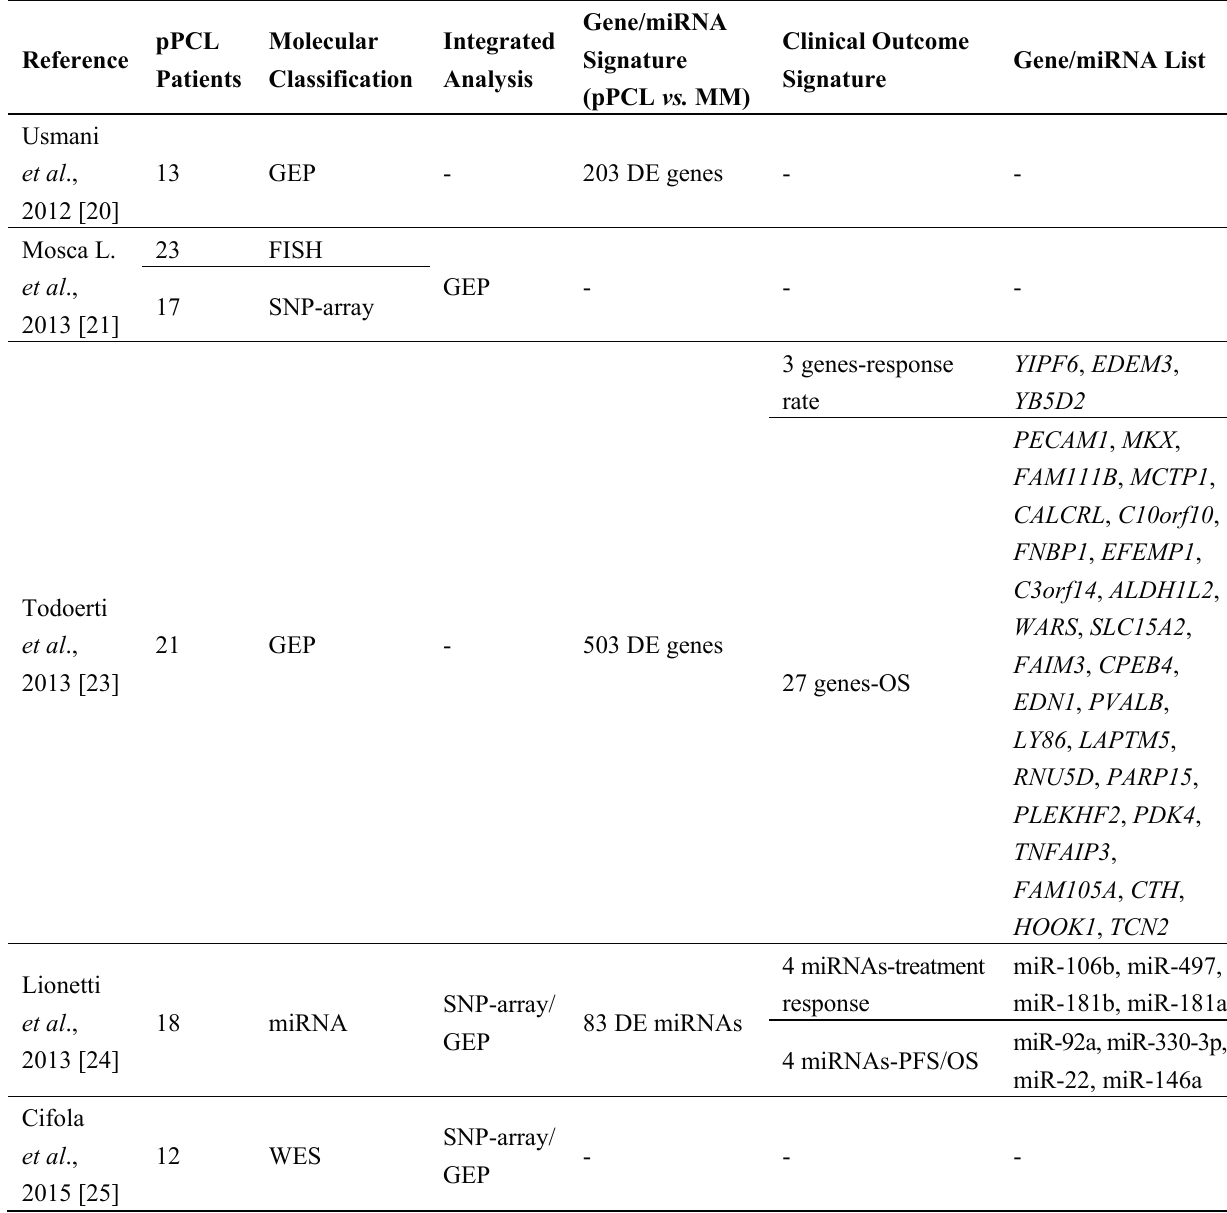
Table 1. High-throughput technologies in pPCL